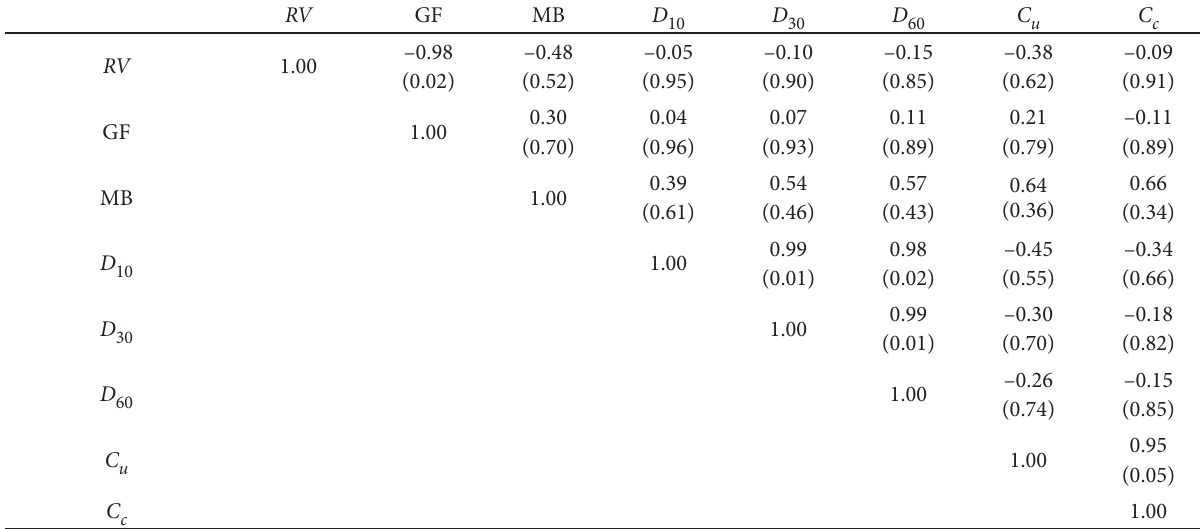
Table 7. Correlation matrix of filler characteristics